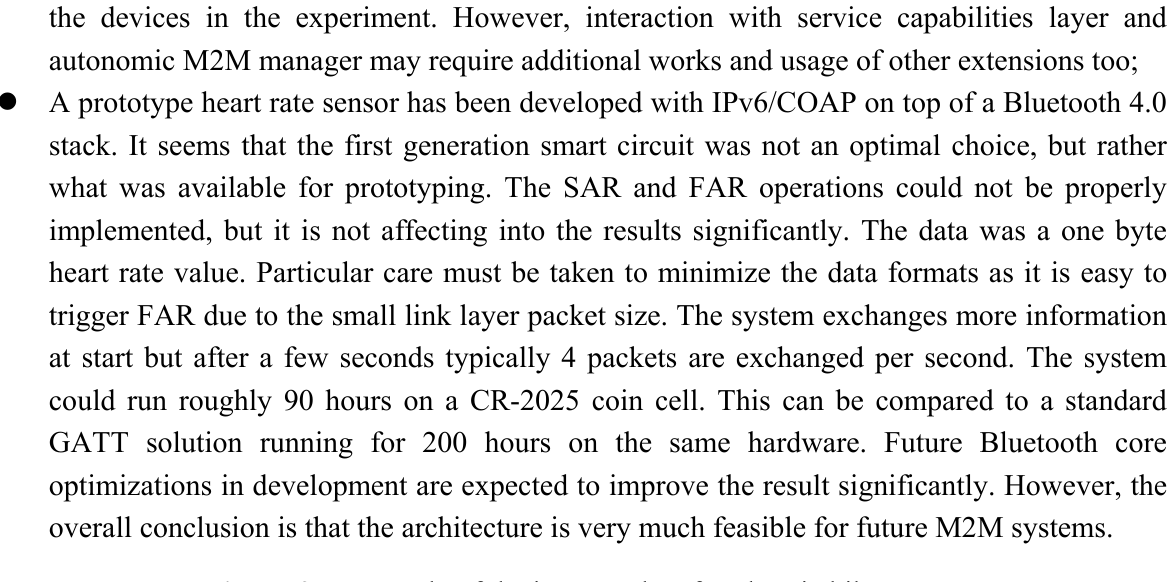
Figure 27. Example of device metadata for electric